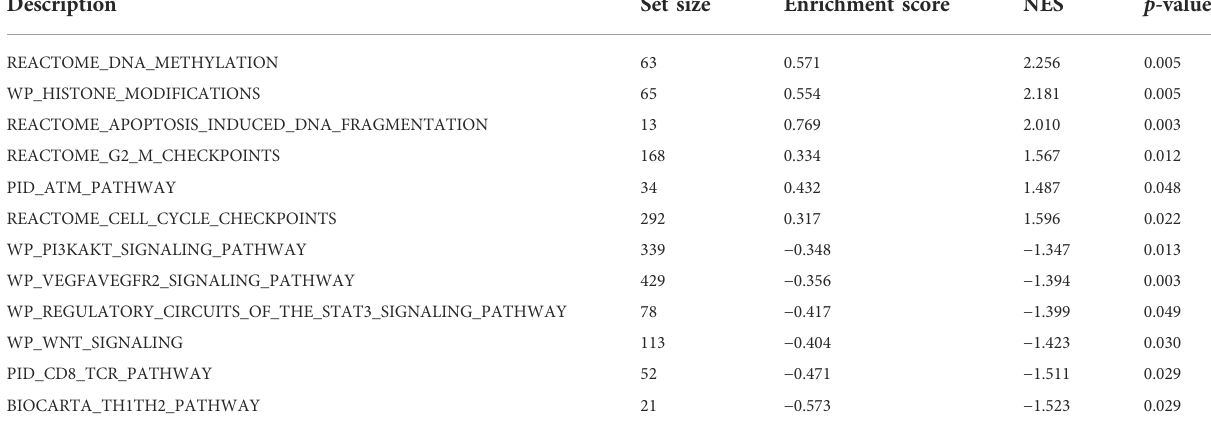
TABLE 3 GSEA enrichment